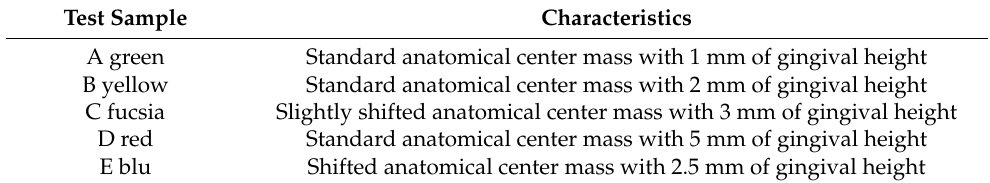
Table 2. Main physical data of the used zirconia.